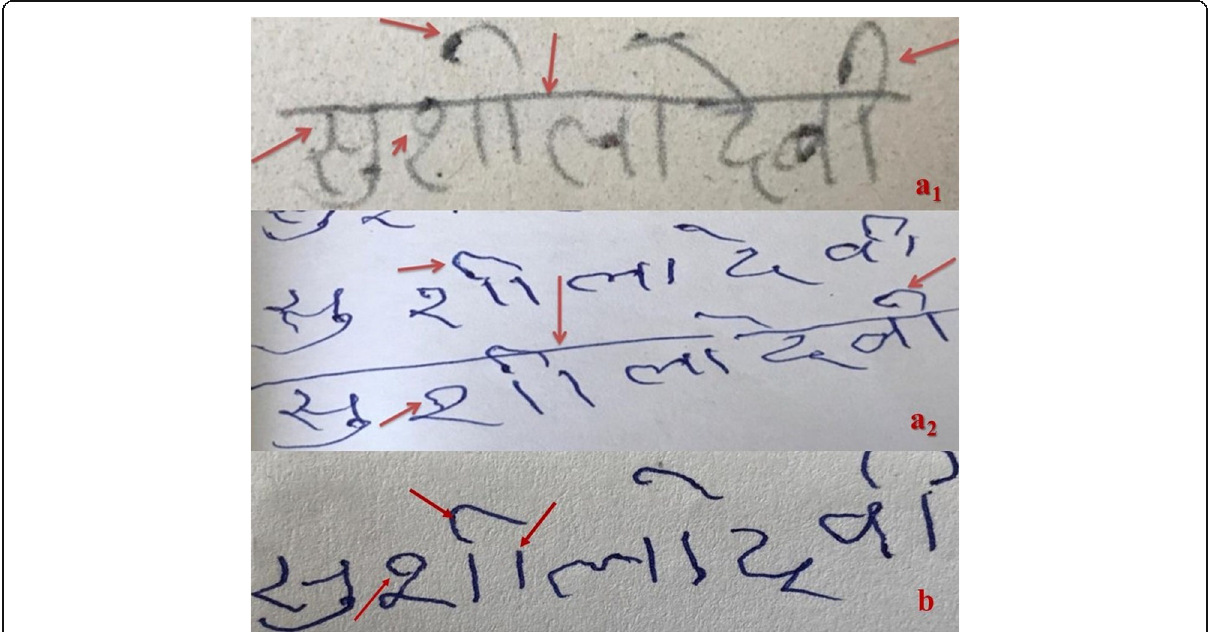
Fig. 4 Letter formation and writing speed. a 1 Handwriting before onset of RA showing no deterioration of letters and fast speed of writing. a 2 Deterioration of letter formation and slow speed in handwriting of RA patient. b Copied writing showing efforts in drawing deteriorated letters of affected writing along slow